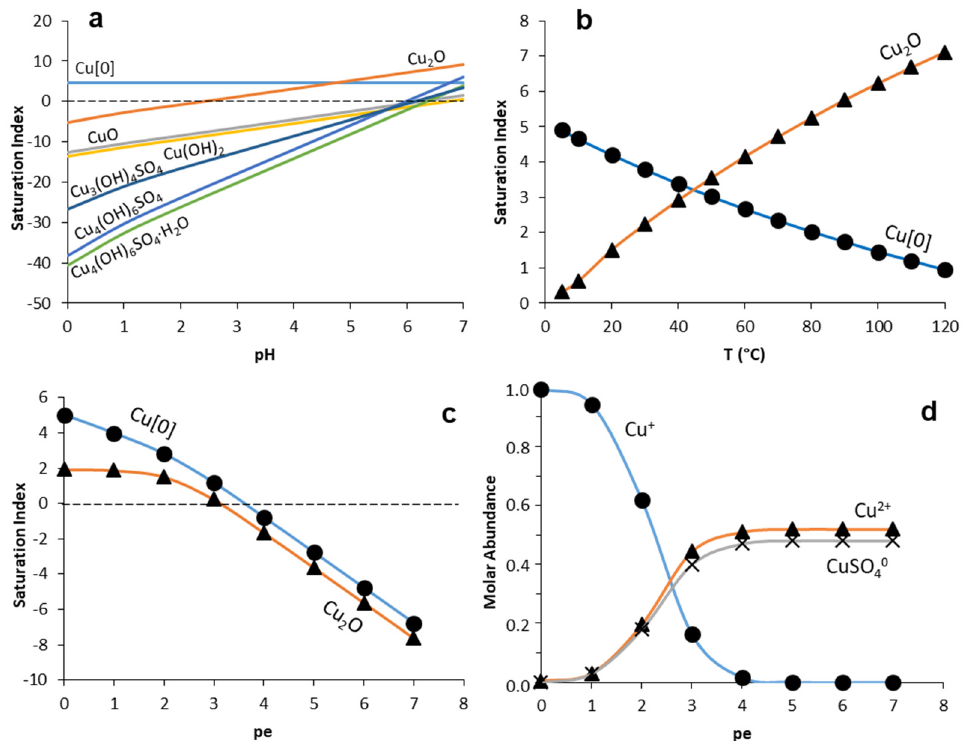
Figure 7. Water/mineral equilibrium trends in the system Cu-O-S at 1 bar: ( a ) Saturation Index of different Cu-containing phases with respect to the Cu(II)-rich acidic solution as a function of pH (pe = 1); ( b ) Evolution of the saturation index of metallic copper (Cu[0]) and cuprite (Cu 2 O) as a function of temperature (T) at conditions of pH = 4 and pe = 1; ( c ) Evolution of the saturation index of Cu[0] and Cu 2 O as a function of electronic potential (pe = Eh/59.2) at conditions of T = 25 °C and pH = 4; ( d ) Molar proportion of major ionic copper species in solution (Cu + , Cu 2+ , CuSO 40 ) as a function of pe. The computations considered in all cases Cu = 3 × 10 − 3 M, S = 0.2 M and O 2 = 2 × 10 − 4